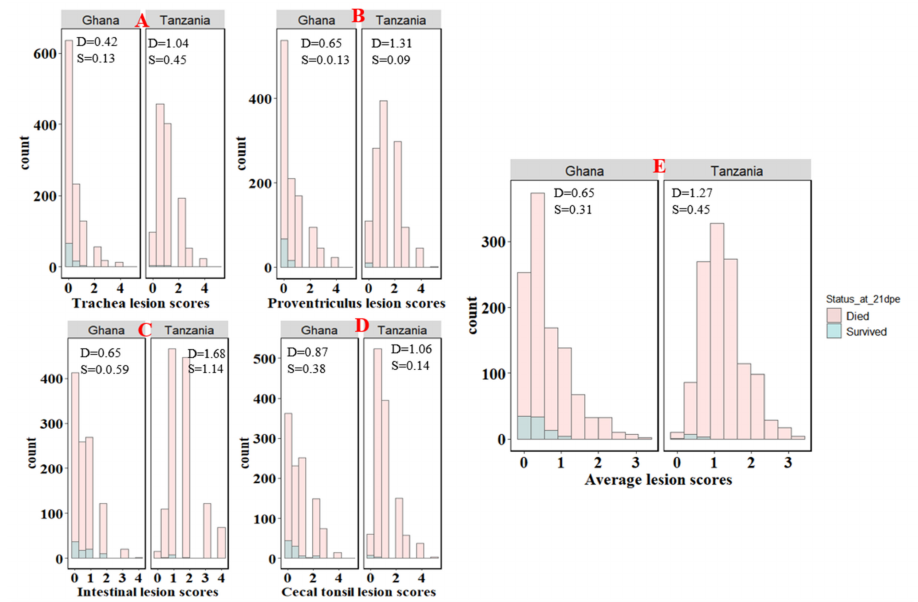
Figure 2. Distributions of lesions scores in ( A ) trachea, ( B ) proventriculus, ( C ) intestine, ( D ) cecal tonsil, and ( E ) average across the four tissues for birds that died and survived to 21 days post exposure (dpe). Numbers in the plots represent the mean scores for the birds that died (D) and survived (S).